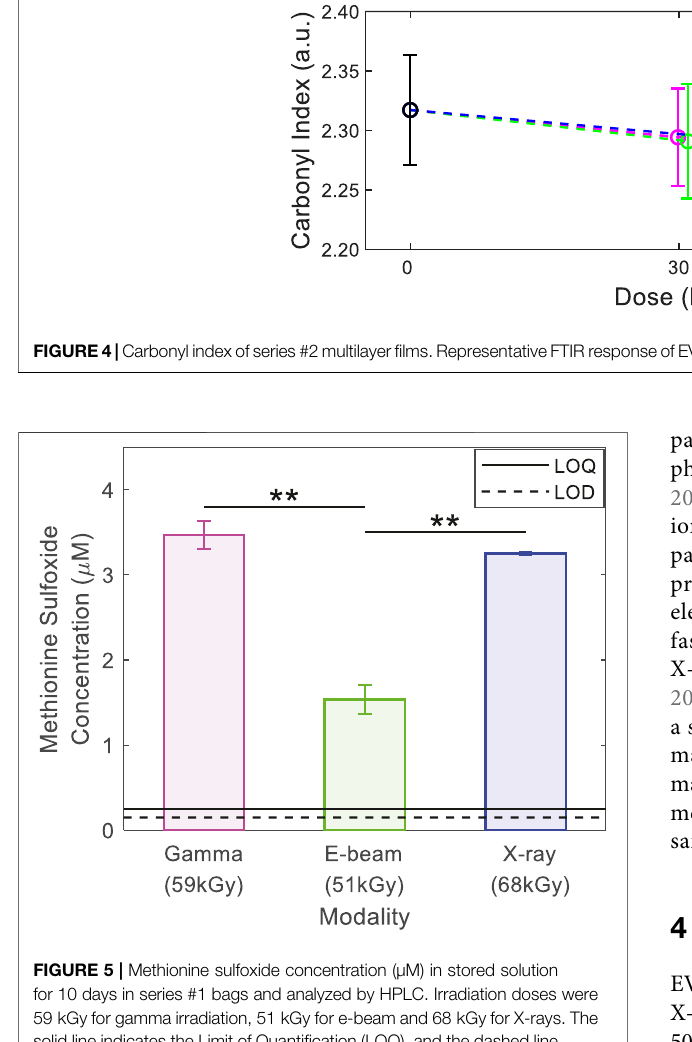
Frontiers in Chemistry |